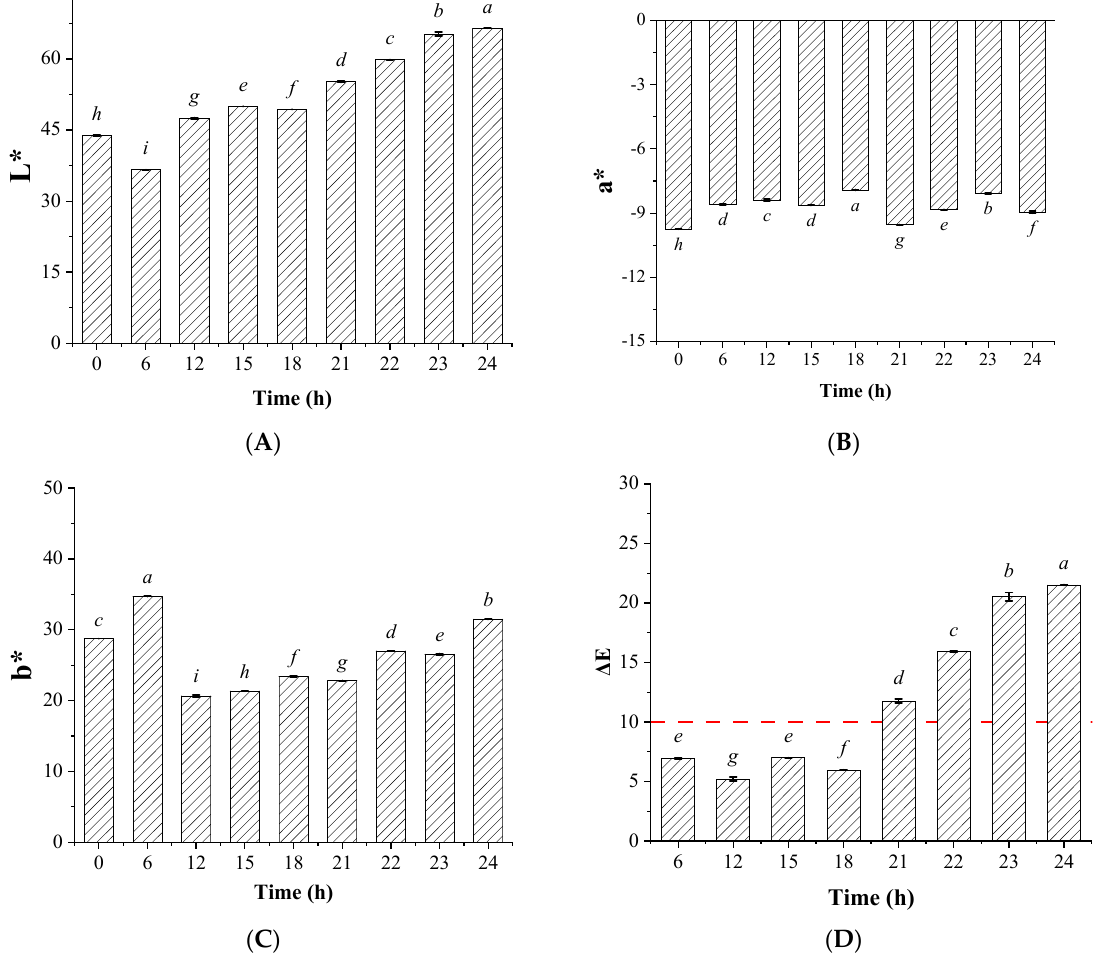
Figure 1. Color index (L*, a*, b*) ( A – C ) and the color-difference index ( ∆ E 00 ) ( D ) of the activated clay bleached soybean oils with illumination pretreatment. The bars with different lowercase letters in the different groups indicate significant difference under p < 0.05; The group without illumination treatment (time for pretreatment was 0 h) was set as the control